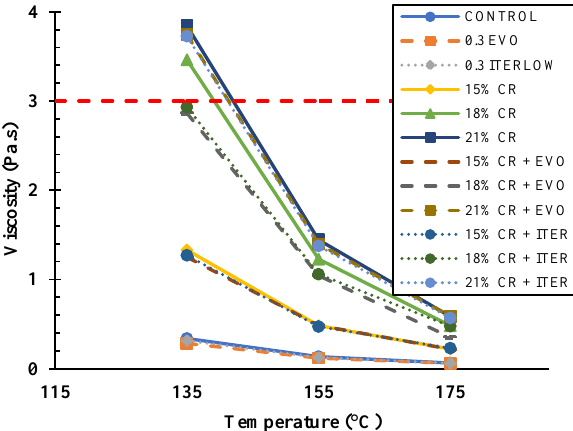
Figure 7. Results of rotational viscosity (RV) test.